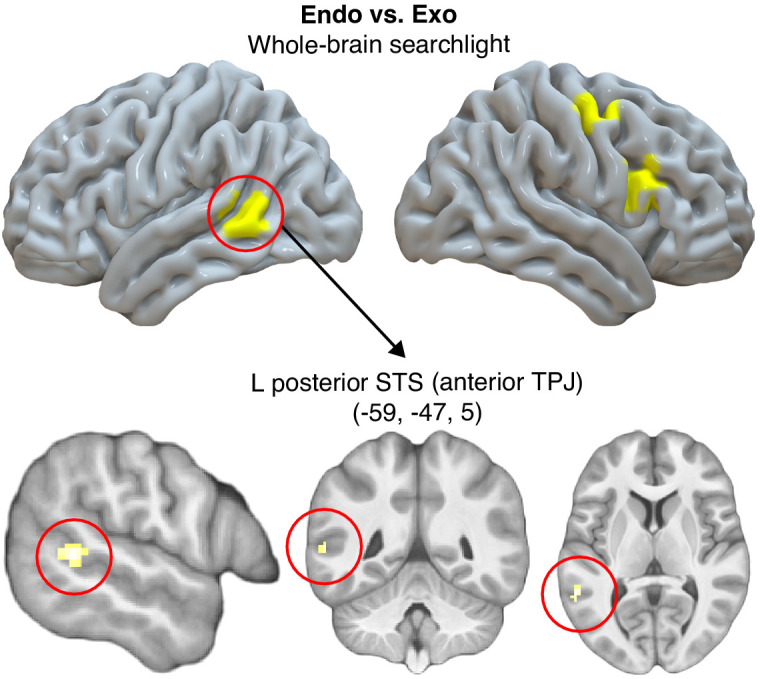
Decoding attention type at the whole-brain level.The cluster shown had the highest decoding accuracy in the whole-brain, searchlight analysis, for the endogenous-versus-exogenous comparison. See Supplementary file 1 for numerical details. Top: projected onto a 3D canonical brain surface. Bottom: projected onto sections of the average structural scan generated from the 32 subjects for anatomical localization. For display purposes, the statistical threshold for the activation maps was set to p<0.001, uncorrected.